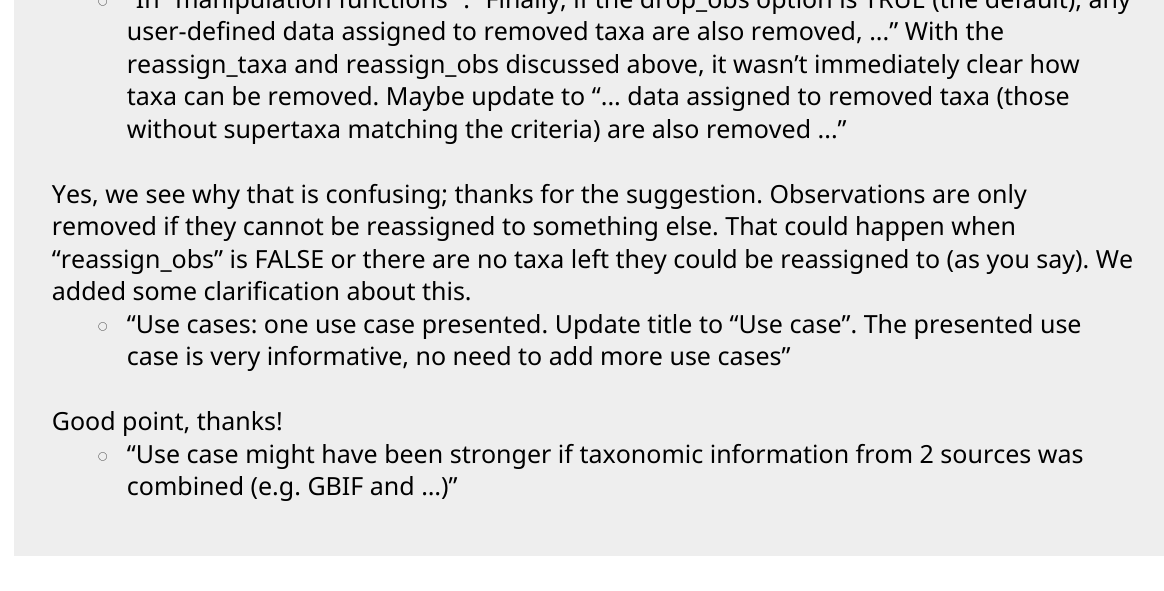
“Figure 1: we found ourselves drawing examples of the classes presented in figure 1. Would maybe be useful to add those to figure? If it is not possible for graphic issues,